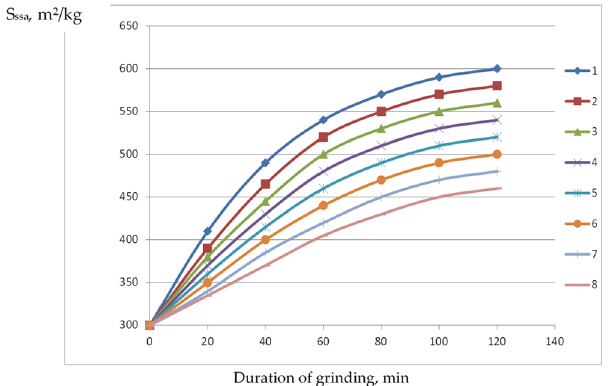
Figure 1. The influence of additives on the specific surface area of CC at different durations of grind-